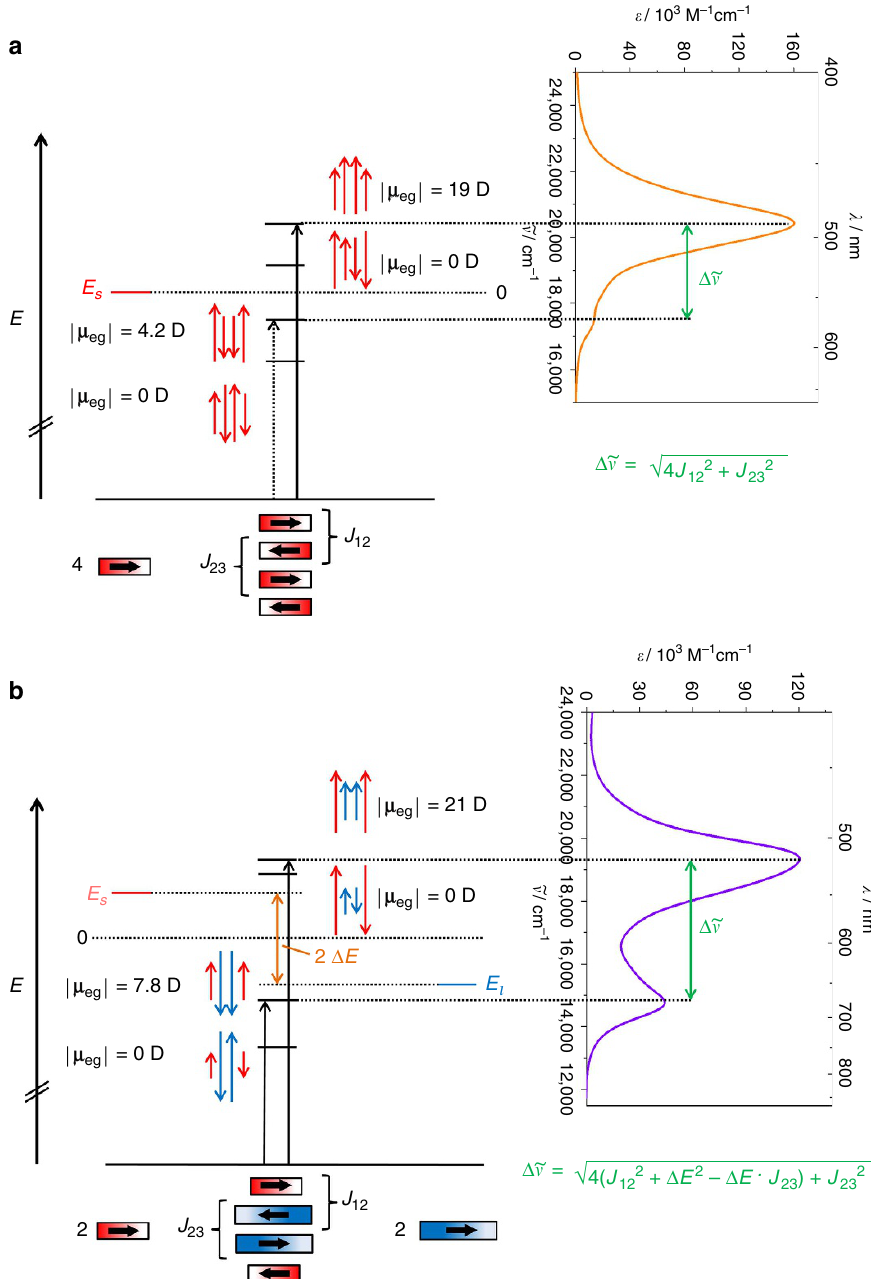
Figure 6 | Exciton state diagram and UV/vis absorption spectra. State diagram and spectra of the quadruple dye stacks of ( a ) bis(merocyanine) 1 and ( b ) bis(merocyanine) 2 . The arrows (red for the short chromophore and blue for the long chromophore, respectively) indicate the phase relations between the corresponding transition dipole moments. The lengths of the arrows reflect the magnitude of the coefficients of the oscillating transition dipole moments. The corresponding experimental dimer spectrum obtained from concentration-dependent UV/vis spectroscopy in chlorobenzene is depicted to indicate the allowed transitions. J 12 and J 23 denote the exciton coupling energies for the chromophore pairs in the exterior and in the interior of the dye stack, respectively, while E s and E l are the excited state energies of the short and long chromophore,